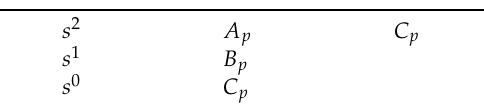
Table 1. Routh array of